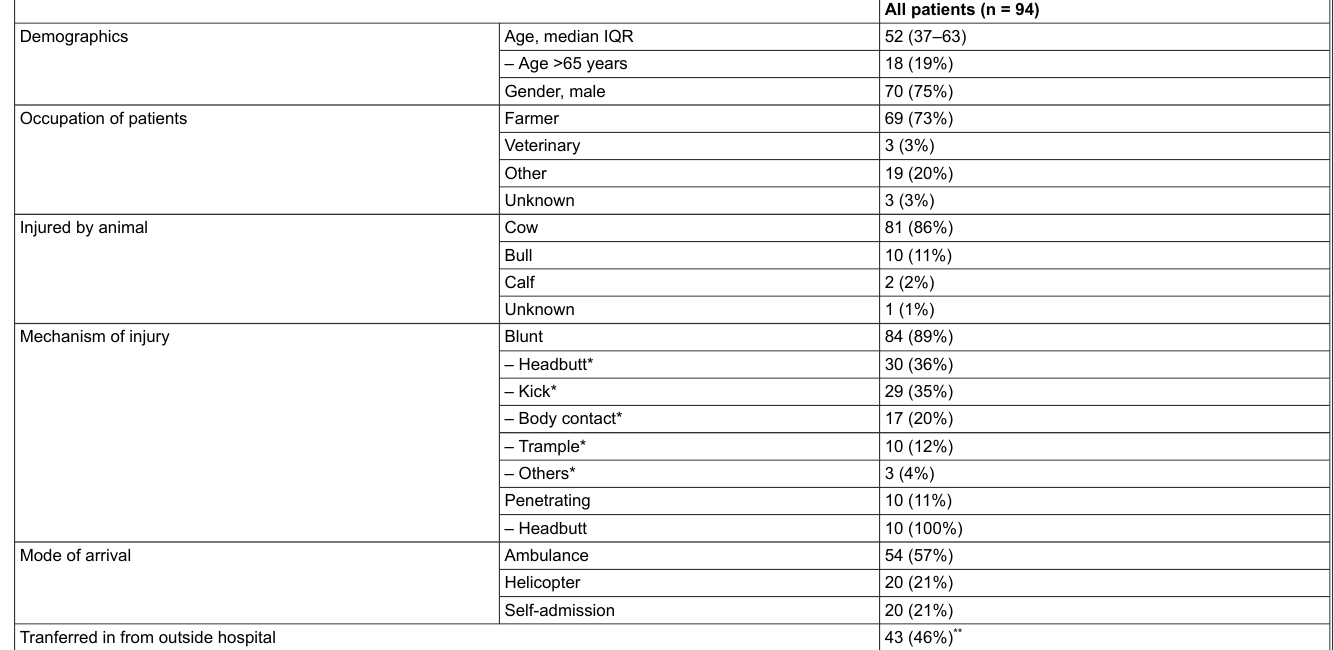
Table 1: Baseline characteristics of patients admitted after cattle-related trauma. Values are numbers (percentages) unless indicated otherwise.